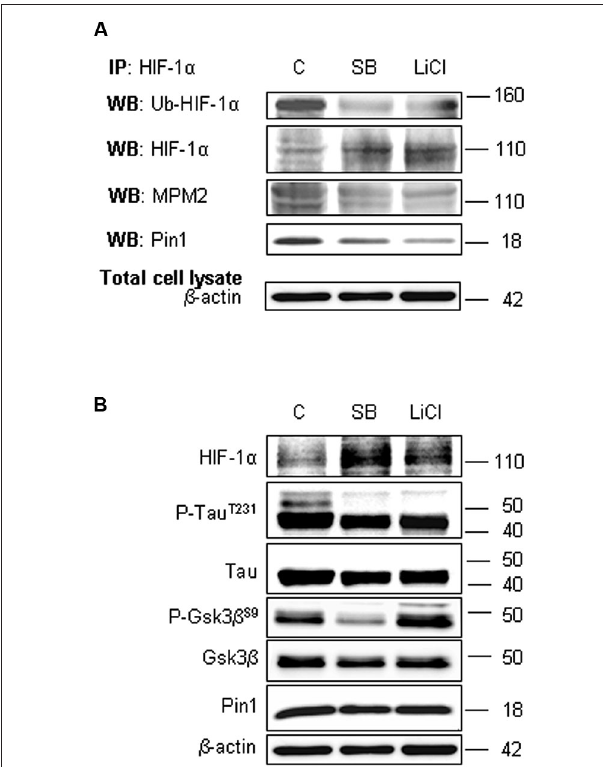
FIGURE 5 | Lithium Chloride (LiCl) or SB-216763 treatment inhibits Gsk-3 β leading to a decrease in HIF-1 α phosphorylation on PSer/Thr-Pro motifs and in HIF-1 α /Pin1 interaction . Cells were treated or not with LiCl 10 mM for 1 h or SB-216763 10 µ M for 3 h. (A) Western blot analysis performed on HIF-1 α immunoprecipitated protein revealed a decrease of the ubiquitination state (anti-ubiquitin), of Ser/Thr-Pro motifs phosphorylation (anti-MPM2) and of Pin1 co-immunoprecipitation (anti-Pin1). (B) Equal amounts of total cell lysates (in the presence of 2% SDS) were subjected to SDS-PAGE and Western blot analysis. HIF-1 α , Tau, P-Tau T231 , Gsk-3 β and P-Gsk-3 β S9 and Pin1 levels were detected by specific antibodies and revealed by ECL. Tau T231 phosphoryalation as well known Gsk-3 β target was assessed to evaluate the kinase inhibition. Anti- β -actin antibody was employed to confirm equal protein loading in the different lanes. IP, immunoprecipitation; WB, western blot; MPM2, antibody against phosphorylated Ser/Thr-Pro motifs.